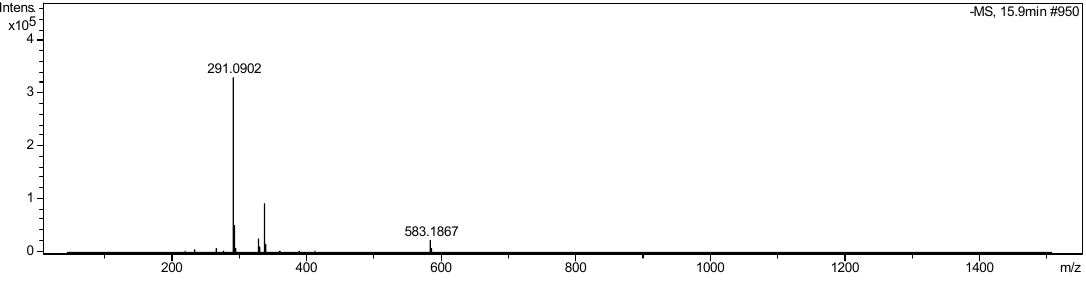
Figure 2. High-resolution mass spectrum of 8-methoxysmyrindiol.